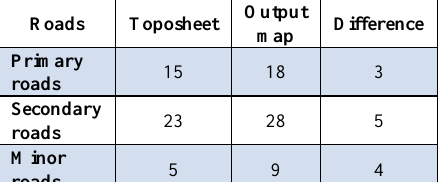
Table 1: Differences of roads in scanned toposheet and